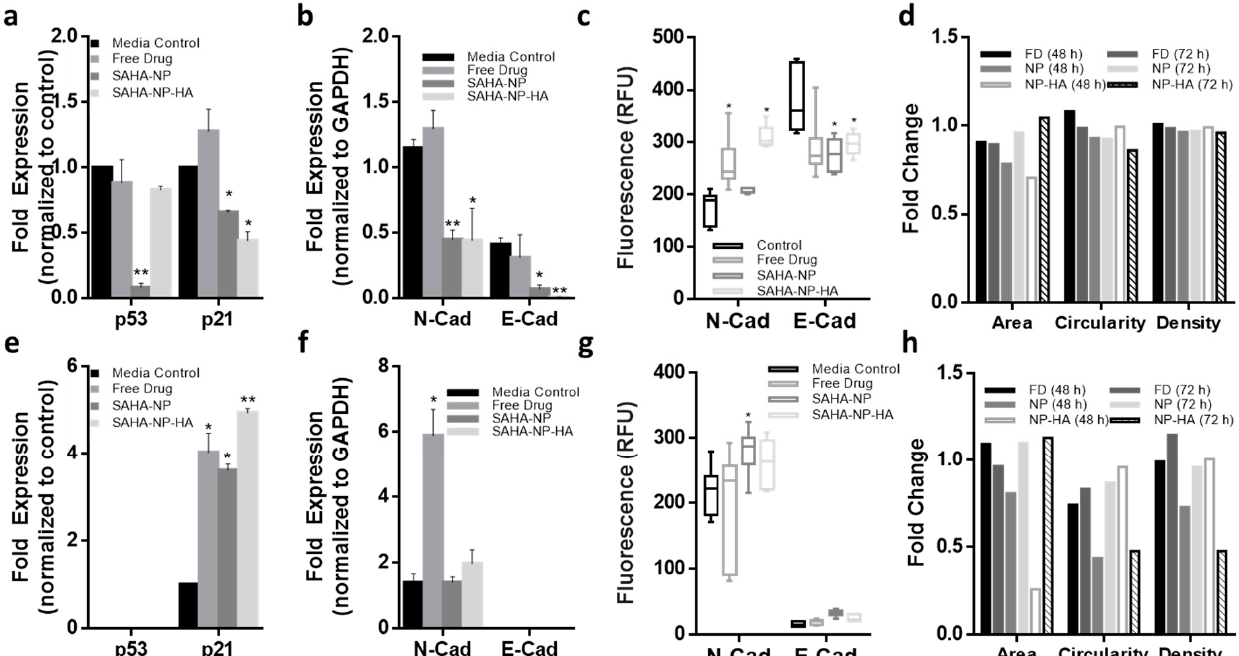
Figure 8. Effect of free and NP- encapsulated SAHA on p21 and p53 expression and molecular phenotype in 3D endometrial cancer models. Protein densitometry of media control (black) SAHA Free Drug (medium grey), SAHA-NP (dark grey) and SAHA-NP-HA (light grey), all treatments were 2.5 µ M for 72 h. Protein analyses on cell cycle arrest markers p53 and p21 in Ishikawa ( a ) and Hec50 ( e ) and molecular phenotype markers E and N cadherin in Ishikawa ( b ) and Hec50 ( f ), * p53 and p21 results are average and standard error, from a minimum of three independent repeats, results are normalized to the untreated control cells and expressed as a ratio compared to housekeeping protein GAPDH density levels. Cadherin values are average and standard error, from a minimum of three independent repeats normalized to GAPDH protein density level only. Cadherin expression in spheroids Quantified immunofluorescence of E and N-cadherin in Ishikawa ( c ) and Hec50 ( g ) spheroids following treatments, relative fluorescence units (RFU) values obtained from ImageJ analysis of immunofluorescence images ( n = 6), RFU per unit area. Spheroid morphology metrics ImageJ analysis of the spheroid images was conducted to ascertain change in area, circularity and density in Ishikawa ( d ) and Hec50 ( h ) following treatments, free drug 48 h (black), free drug 72 h (dark grey), SAHA-NP 48 h (medium grey), SAHA-NP 72 h (light grey), SAHA-NP-HA 48 h (white with grey outline) and SAHA-NP-HA 72 h (striped). All data was normalized to untreated control spheroids. Statistical significance is indicated on graphs: p ≤ 0.05 denoted by * and p ≤ 0.01 by **.